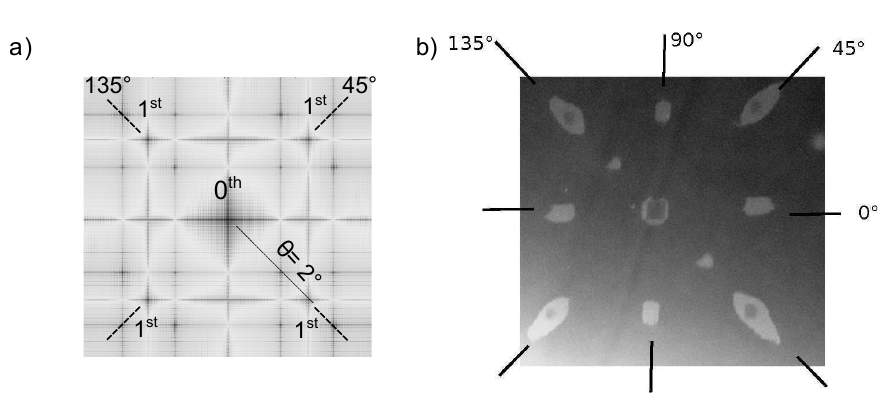
Figure 6. Stokesmeter pattern at Witness Plate 1 (Figure 1). ( a ) Simulation obtained with a tip-to-tip gap of 5 nm; ( b ) experimental pattern on the photo-resist.